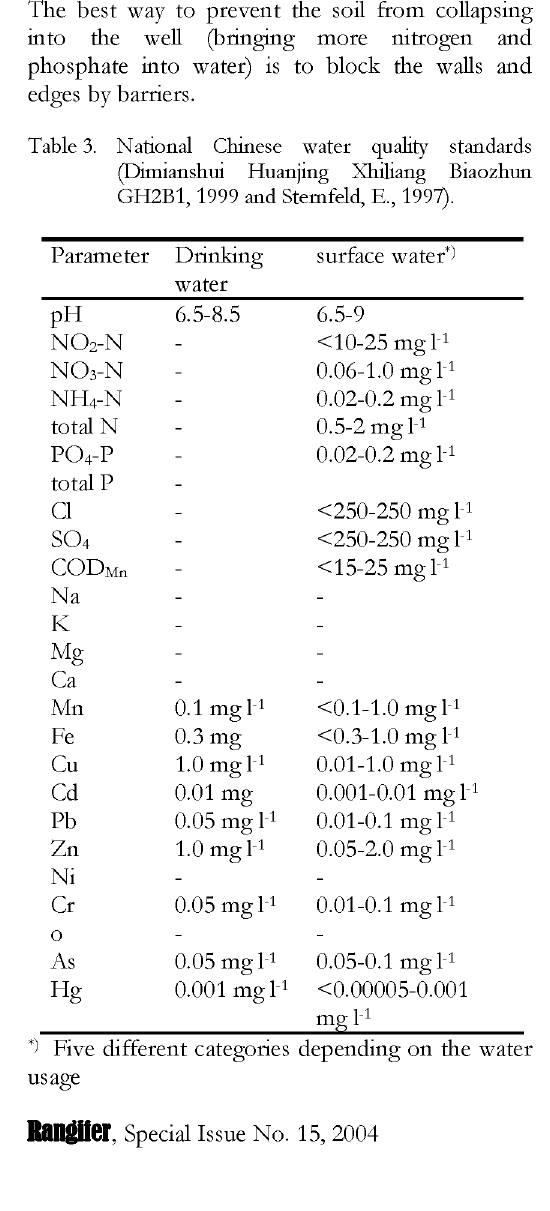
Table 3. National Chinese water quality standards (Dimianshui Huanjing Xhiliang